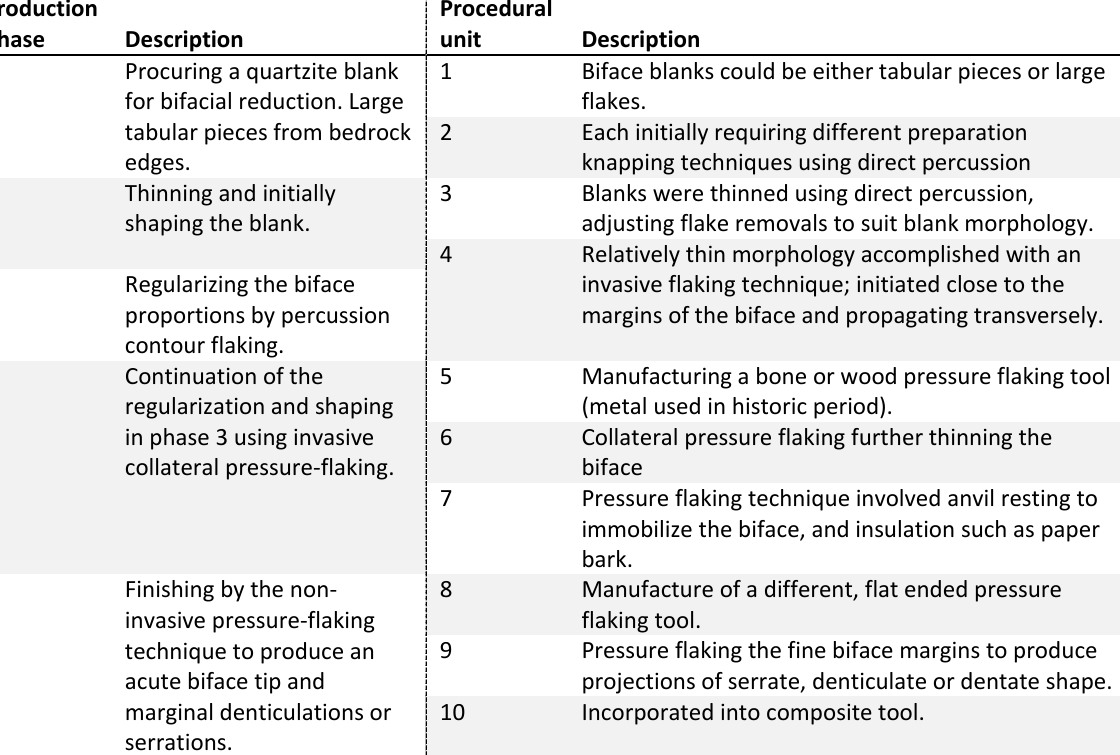
Table 1. List of production phases by Moore (2015) and procedural units by Maloney